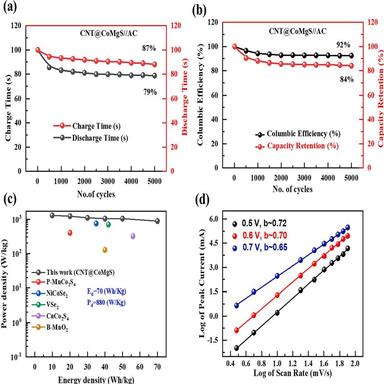
(a) charging/discharging time as a function cycles. (b) Columbic efficiency and specific capacity retention of the HSCs. (c) Estimated b-value for the real device of (CNT@CoMgS//AC). (d) Represent the comparison of power density against energy density.